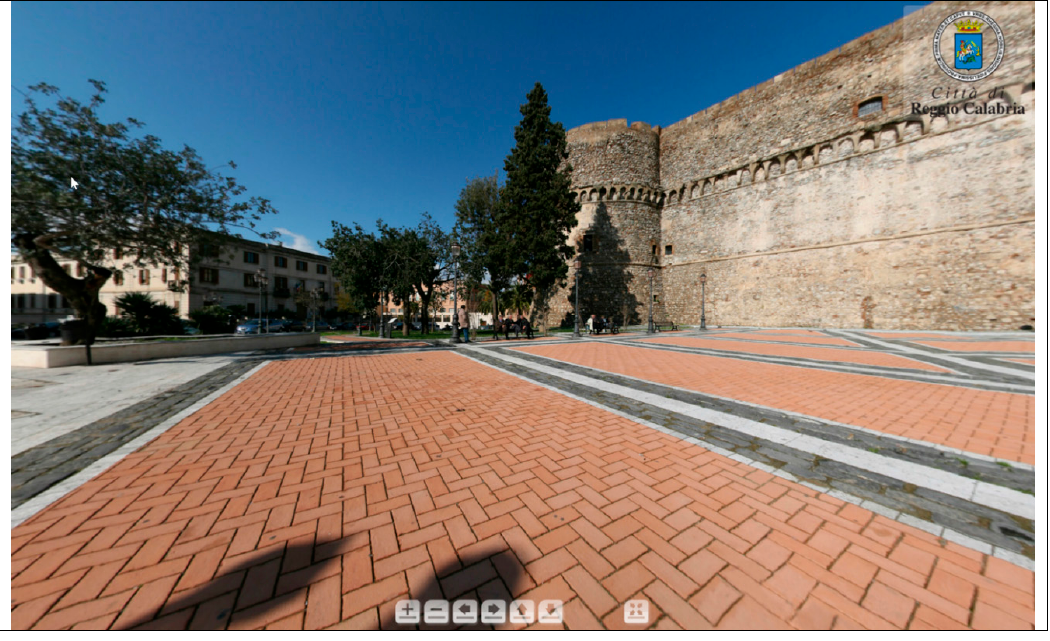
Figure 5: “Castello Aragonese—Reggio Calabria”. Command bar only [26].